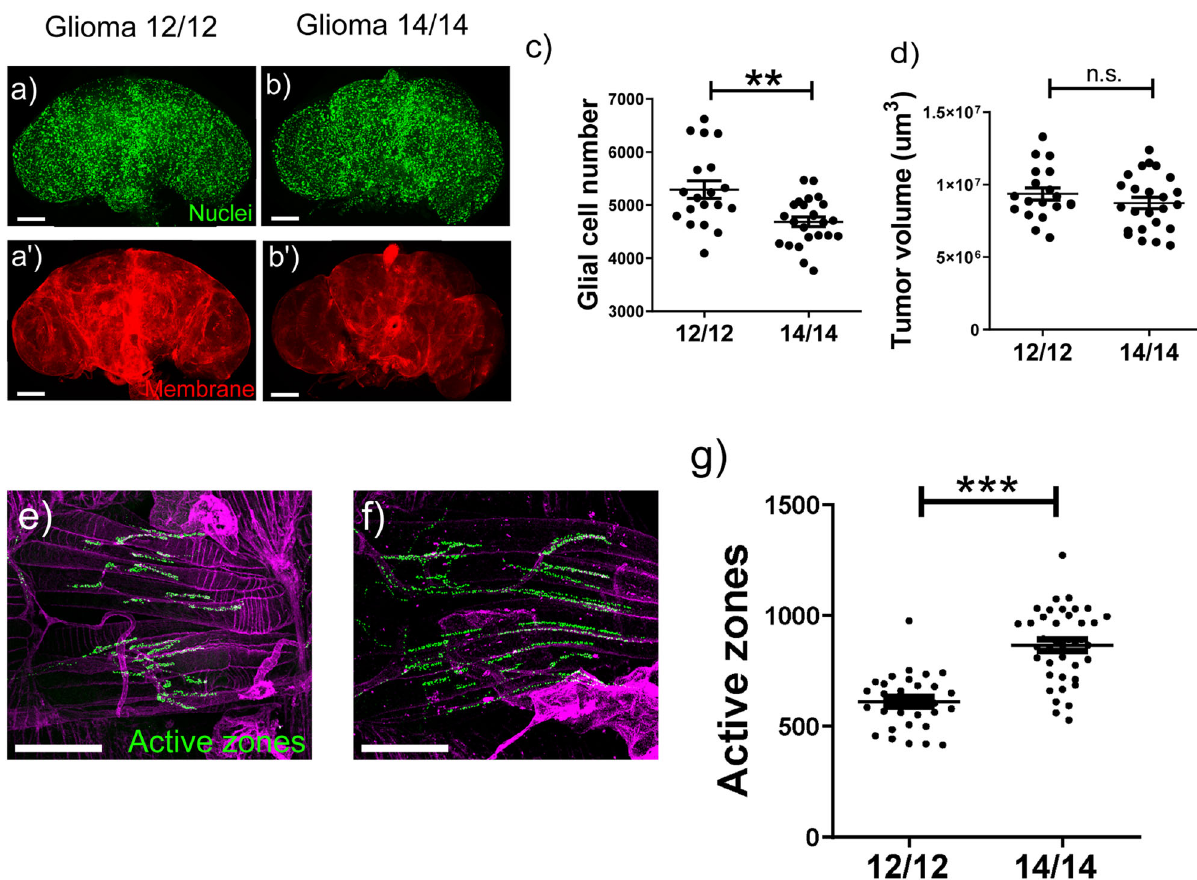
Fig. 5 Re-adjusting environmental cues to internal rhythms after GB induction reduces tumor proliferation. a , b Confocal microscopy images of the whole adult brain from control and treated glioma fl ies. After 4 days of tumor onset under regular 12:12 L:D conditions, animals were maintained in either 12:12 or 14:14 L:D conditions. Glial membrane is tagged in red and glial nucleus in green. c , d Quanti fi cation of glial cell number and glial membrane volume of the whole brain per animal, N > 18 fl ies (ANOVA, post-hoc Bonferroni) (scale bar, 100 µ m) (** p -value<0,01). e , f Confocal microscopy images of adult NMJ from glioma 12:12 and 14:14. ( e ) and GT ( f ) fl ies. Active zones are tagged in green. g Quanti fi cation of active zones per animal for GC and GT, N = 31 fl ies (ANOVA, post-hoc Bonferroni) (scale bar, 50 µ m) (*** p -value < 0.001).